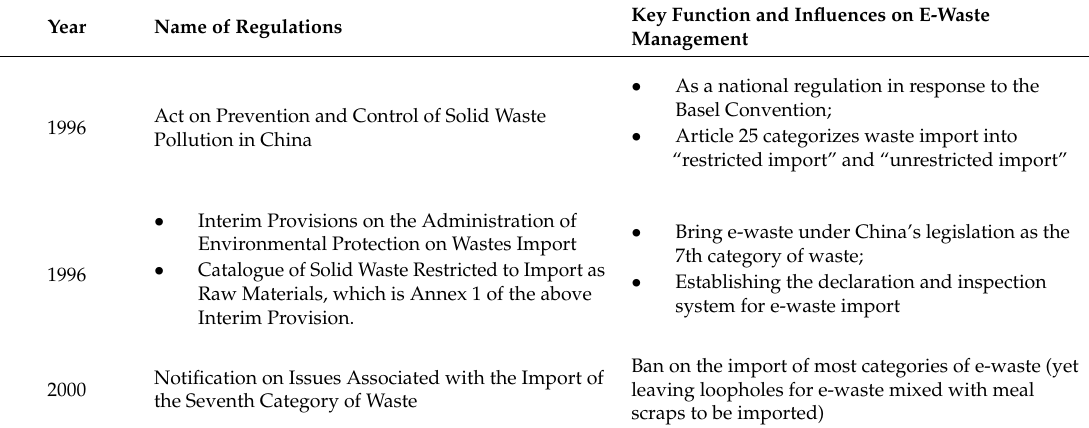
Table 4. China’s key legislation on e-waste before the new